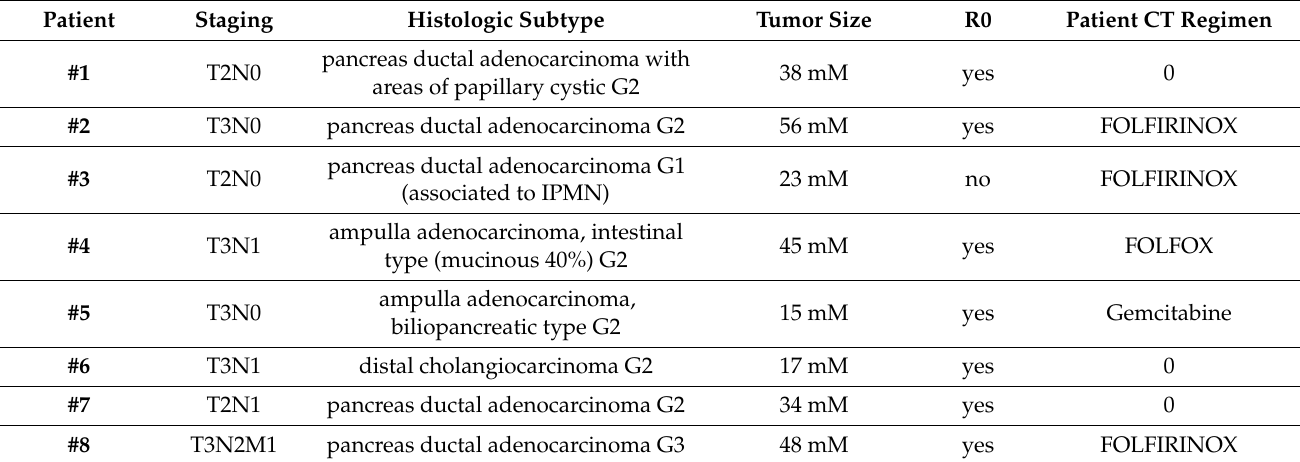
Table 1. Clinical characterization of patients included in the